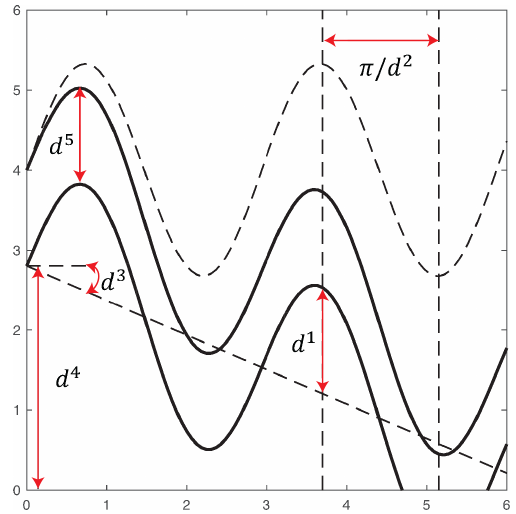
Figure 1. Geometrical configuration of channel flow: amplitude d 1 , frequency d 2 , angle d 3 , initial point d 4 and width d 5